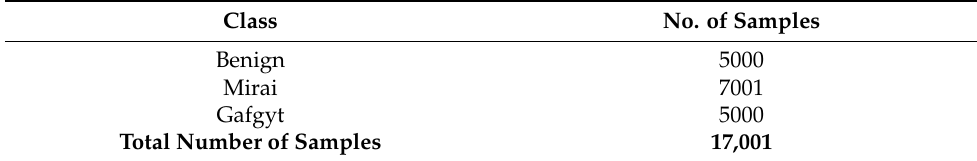
Table 1. Dataset details.